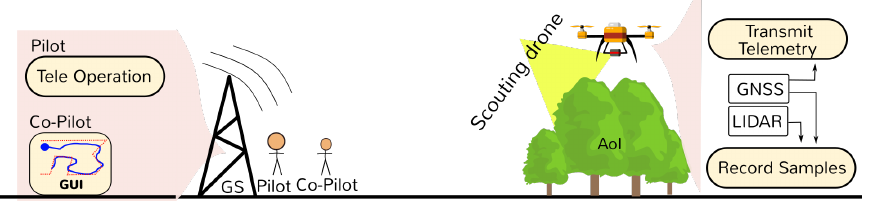
Figure 2. Scouting phase—flight.